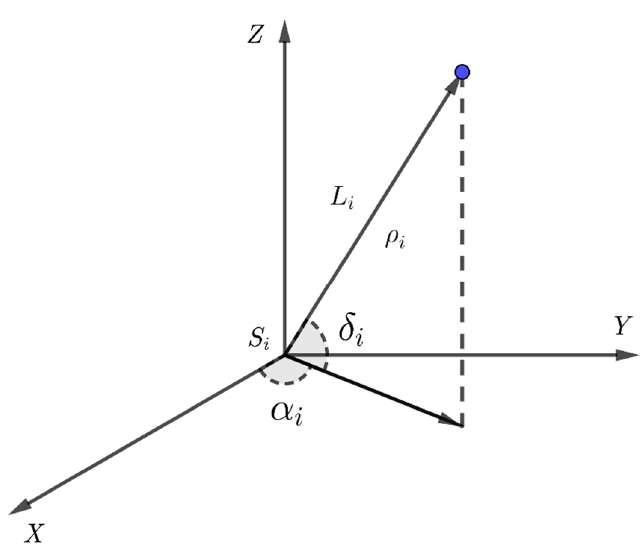
Figure 2. The right ascension and declination of an LOS vector.